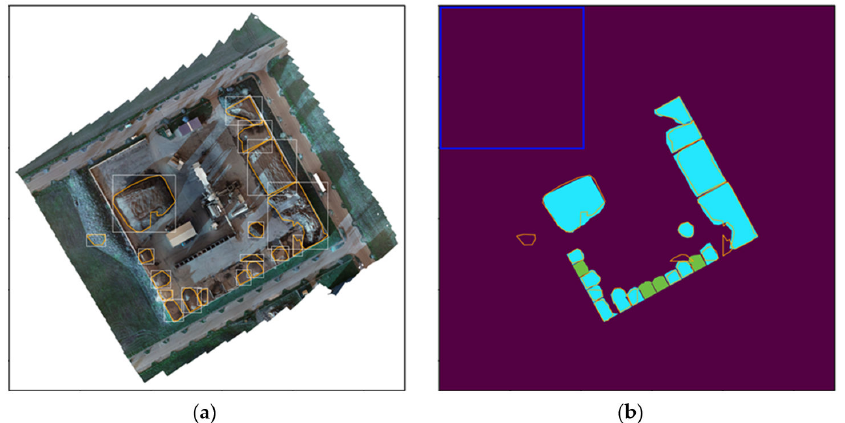
Figure 16. Results on Test Site A. ( a ) Boundary polygons (orange) and bounding boxes (white) plotted on top of the RGB orthomosaic; ( b ) Boundary polygons plotted on top of the ground truth masks. Light-blue masks denote true positives, green masks denote false negatives. The blue square in the upper-left corner illustrates the size of a single sliding window position in relation to the size of the whole site.